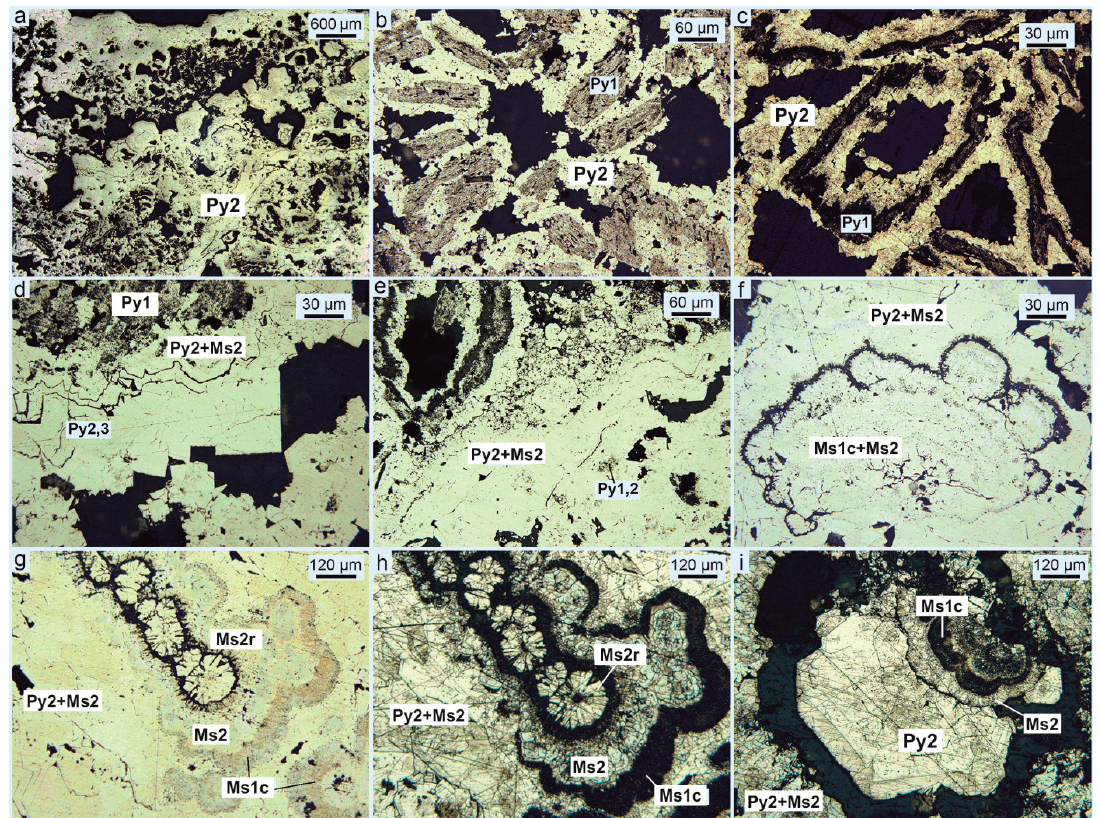
Figure 8. Varieties of pyrite in reniform-rich pyrite microfacies of the hydrothermal crusts (sample 37L-107-10). Pobeda-2 hydrothermal field. ( a ) porous marcasite-pyrite (Py2) crust; ( b ) pseudomorphic spongy pyrite-1 (Py1) is overgrown by anhedral and subhedral crystals of pyrite (Py2); ( c ) pyrite-2 (Py2) aggregates envelop and drape over boxy spongy pyrite pseudomorphs (Py1) after pyrrhotite; ( d ) successive overgrowth of pyrite-1 (Py1) by subhedral marcasite (Py2+Ms2) and pyrite (Py2,3); ( e ) brecciated marcasite-pyrite (Py2+Ms2) aggregates; ( f ) reniform marcasite-1 and -2 (Ms1c+Ms2) in crystalline marcasite-pyrite (Py2+Ms2) aggregates; (g,h,i) overgrowth of colloform (Ms1c) and radiated (Ms2r) marcasite by crystalline marcasite (Ms2) and marcasite-pyrite (Py2+Ms2) aggregates. Reflected light. Some pyrite varieties (c,h,i) are etched by HNO 3 + CaF 2